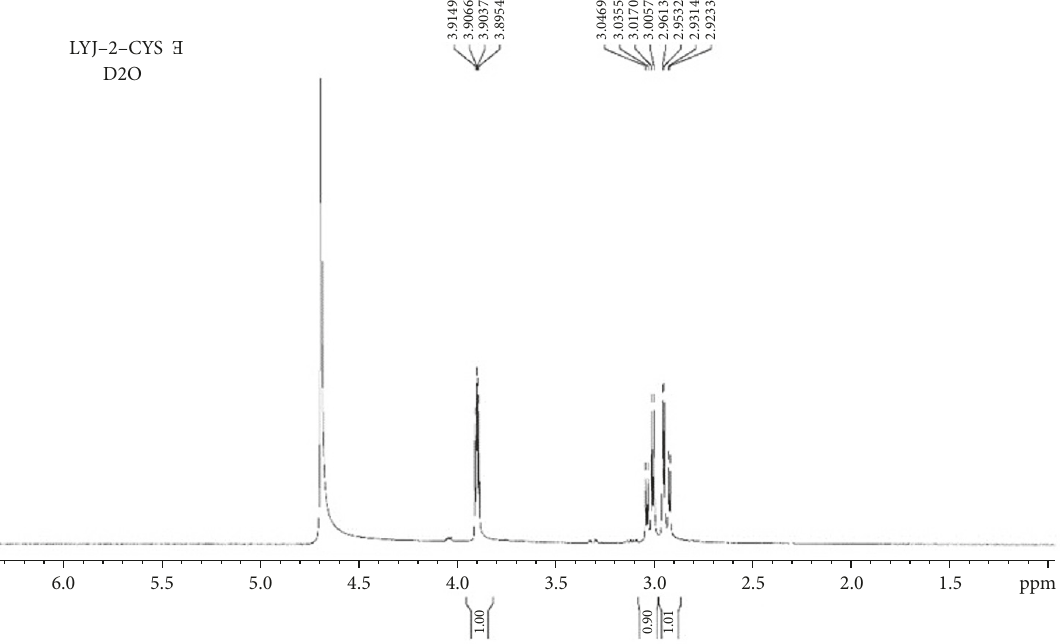
Figure 7: H-NMR spectra of Cys in D 2 O.